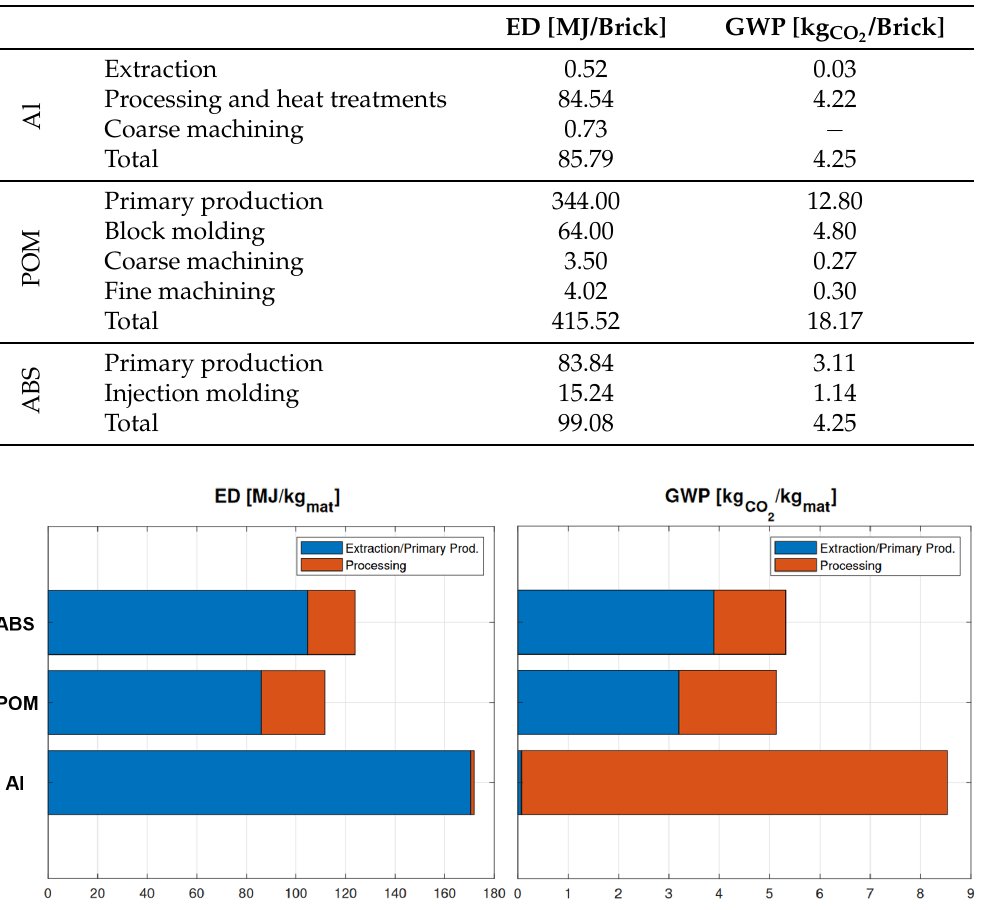
Figure 4. Average ED and GWP per unit of mass related to the ABS, POM, and aluminum extraction and primary production processes.